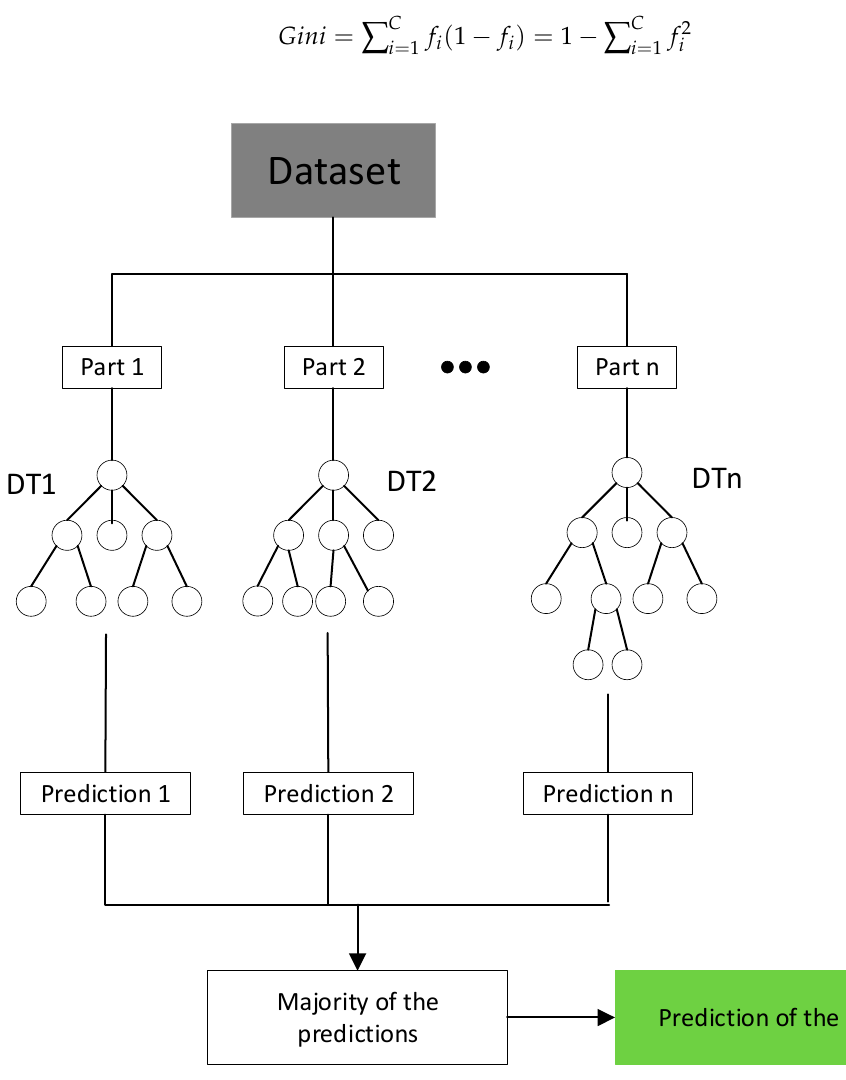
Figure 4. Conceptual representation of the Random Forest algorithm.